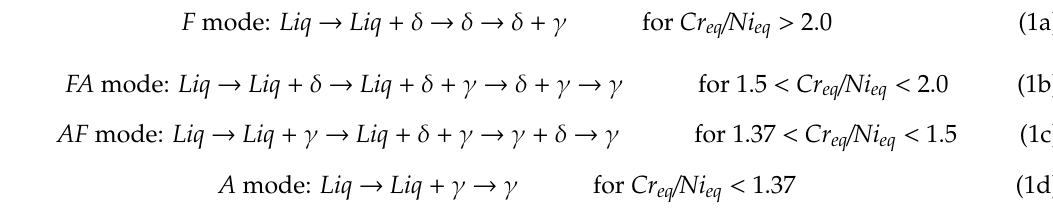
Figure 9. CTOD fracture toughness of walls.